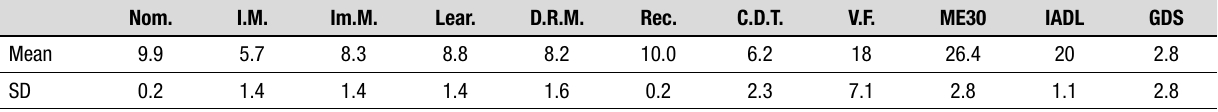
Table 1. Means and standard deviation for the brief cognitive screening battery, Mini-Mental State Examination, Lawton Instrumental Activities of Daily Living Scale, and Geriatric Depression Scale.